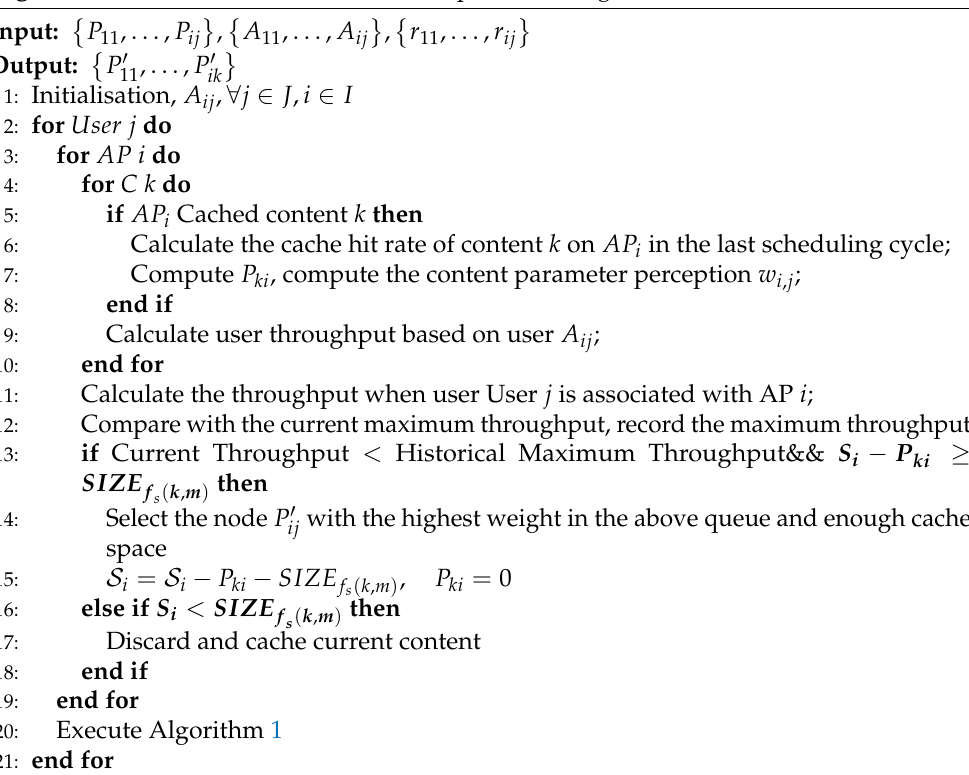
Algorithm 2 Content-aware content cache placement